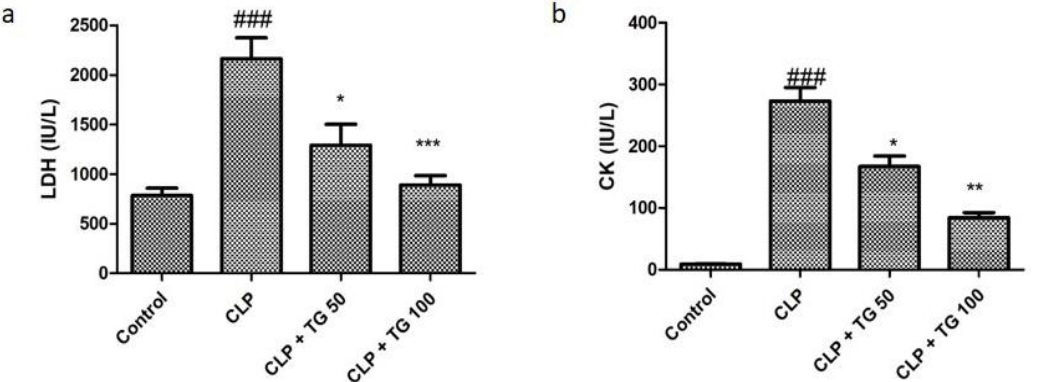
Figure 1. Cardiac injuries were measured by plasma. ( a ) Lactate dehydrogenase (LDH) and ( b ) Creatinine kinase (CK). LDH and CK plasma levels were increased in cecum ligation and puncture (CLP)-treated rats. The CLP-induced cardiac injury was significantly attenuated by tangeretin (TG) (50 and 100 mg / kg) treatment, dose dependently. One-way analysis of variance (ANOVA), followed by Tukey’s test were used for statically analysis (Significance level * p < 0.05). Values represented as means ± SD and n = 12 / group. Where, ### p < 0.001 when compared to control group, whereas * p < 0.05, ** p < 0.01 and *** p < 0.001 when compared CLP group animals.